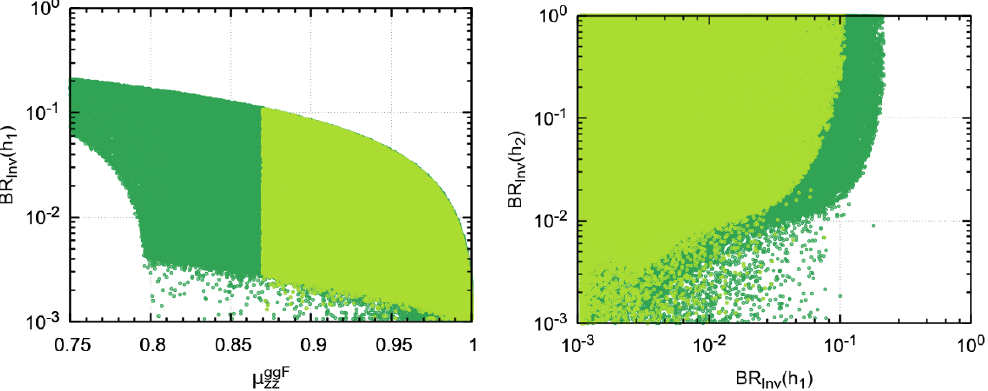
Figure 6 . Left panel: BR inv versus v L . Right panel: BR inv versus M 2 . In dark green the LHC constraints are imposed at 3 (cid:27) , while in yellow green is shown the result of requiring 2 (cid:27) LHC constraints.